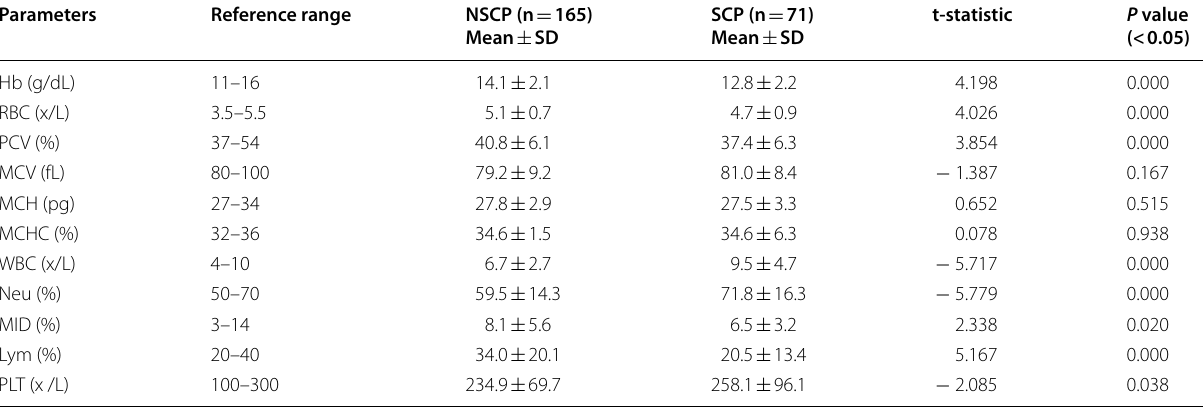
The P value is provided for comparison between the NSCP and SCP groups t-statistic shows the statistical difference between the means of NSCP and SCP